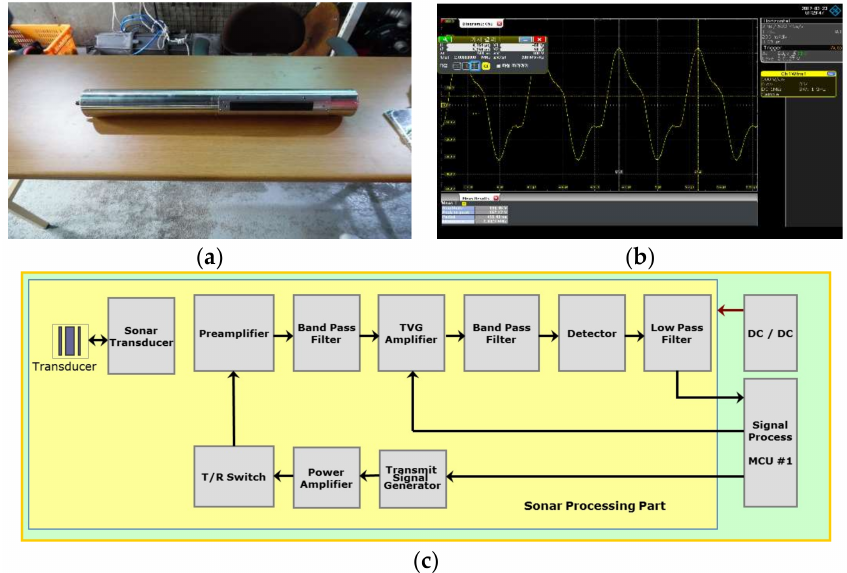
Figure 3. 2 MHz Side Scan Sonar. ( a ) 2 MHz Sonar; ( b ) Result of oscilloscope; ( c ) Block diagram of processing.